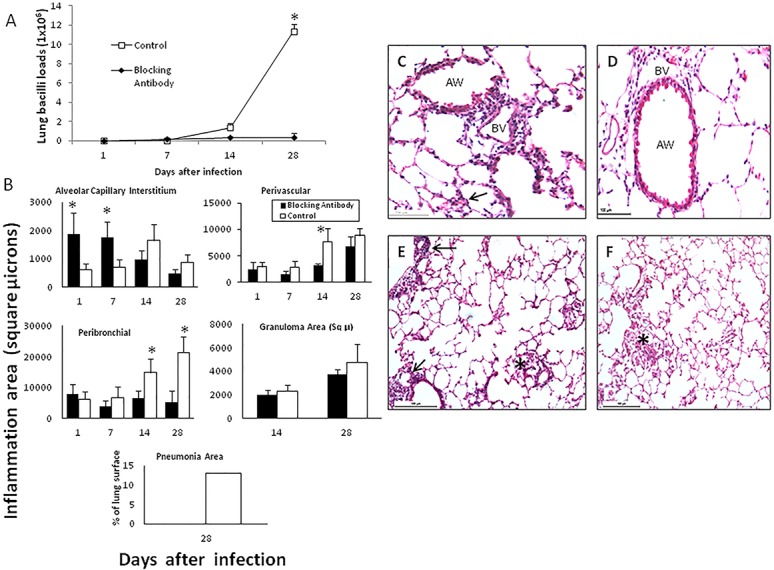
Effect of blocking HMGB1 during early infection on bacilli loads and inflammation.(A) Groups of infected BALB/c mice with M.tuberculosis strain H37Rv were treated with blocking specific antibodies against HMGB1 administered each other day since the first day of infection and during three weeks (solid symbols); control animals received isotype irrelevant chicken antibodies (white symbols). (B) The lungs from three mice per each sacrifice day were used to determine the area in square microns occupied by inflammatory cells in the indicated lung compartment, in mice treated with HMGB1 blocking antibodies (black bars) and control group (white bars). Asterisks represent statistical significance (p<0.05 student T test). (C) Representative lung micrograph from a mouse treated with blocking HMGB1 antibodies after one week of infection, there are numerous lymphocytes around blood vessels (BV), airways (AW) and alveolar-capillary interstitium (arrow). (D) In contrast, control mouse show lower inflammation in the same lung compartments after 7 days of infection. (E) After one month of infection, the lung of mouse treated with blocking antibodies shows high inflammatory response around blood vessels (arrows) and in the interstitium (asterisk) but there is not pneumonia. (F) In comparison, the lung of control mouse show focal patches of pneumonia (asterisk). (All figures H/E staining, scale bar = 100μ).